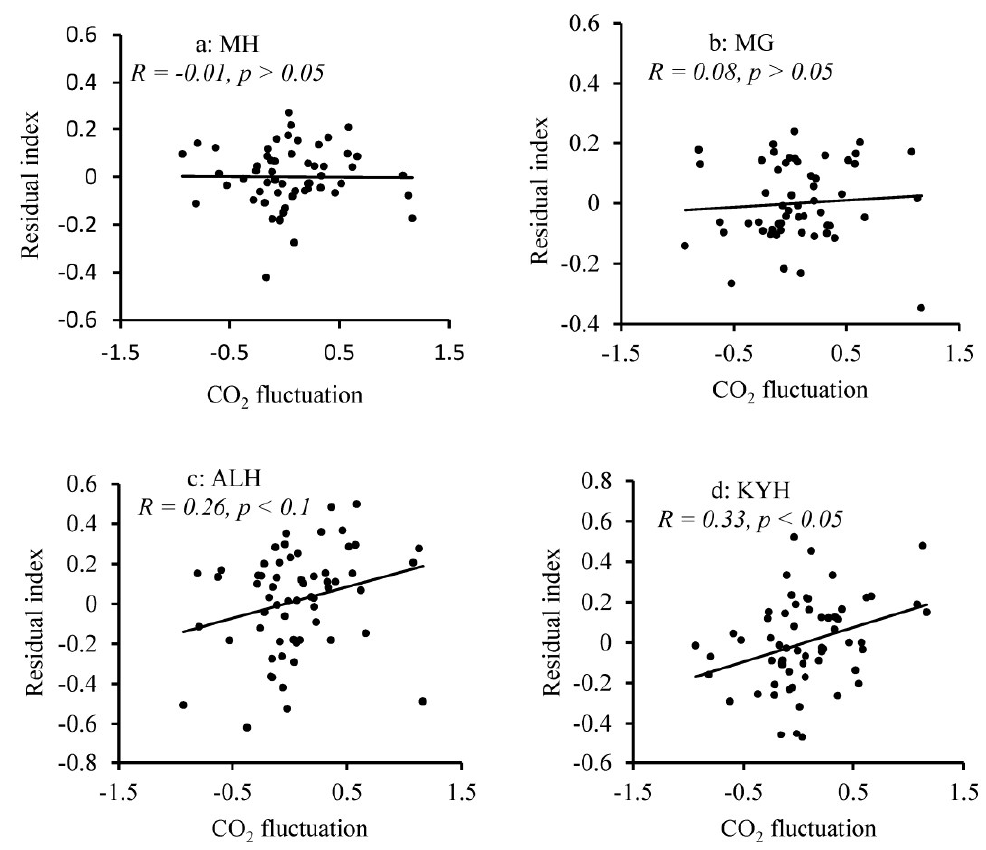
Figure 6. Comparison of the tree-ring residual indices and CO 2 interannual fluctuation (the first order annual di ff erence of the CO 2 concentration) for four sites during the common period.